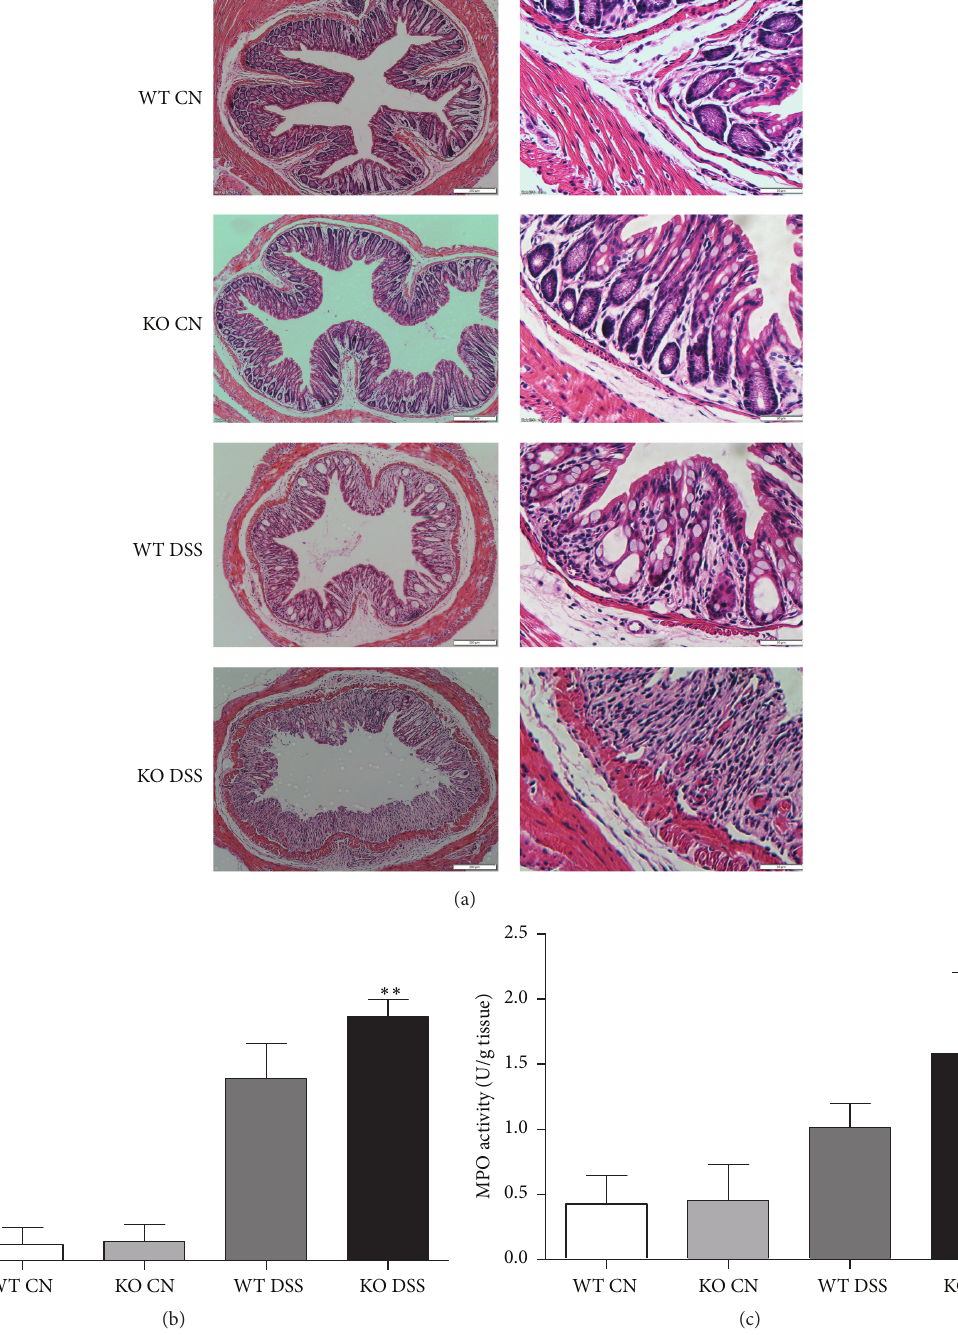
Figure 2: Effect of TRAF5 deficiency on the histopathology and MPO activities of colon tissues. Histological evaluation of DSS-induced colitis was performed by microscopy and H&E staining. Colon sections from TRAF5 KO and WT mice were scored in a blinded fashion, as described in Section 2. (a) Representative cross sections of the distal colon. The magnifications of the images are 100-fold and 400-fold. (b) Quantitative results of the histological analysis ( 𝑁 = 10 per group). (c) MPO activities in the colons were determined as described in Section 2 ( 𝑁 = 6 per group). The data are presented as the mean ± SD. ∗ 𝑝 < 0.05 versus the DSS-treated WT group and ∗∗ 𝑝 < 0.01 versus the DSS-treated WT